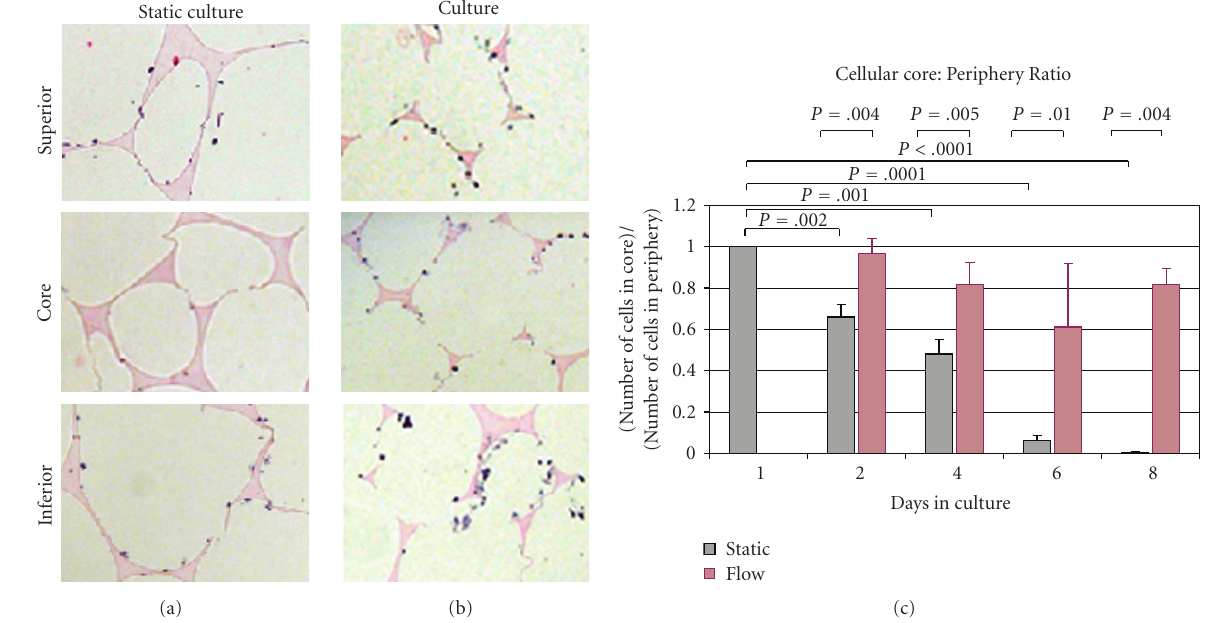
Figure 6: (a) Dividing the sca ff old into thirds, the core of static cultured sca ff olds was nearly void of cells by day 4. Cell density was preserved in the peripheral crust (superior and inferior thirds). (b) Sca ff olds exposed to flow-perfusion culture exhibit a near homogenous cell density in all areas of the sca ff old, with evident cell viability in the core, in contrast to the static cultured samples. (c) To account for the possibility of confounding shear stress or di ff erences in cell proliferation in dynamic versus static culture, the core : periphery ratio was